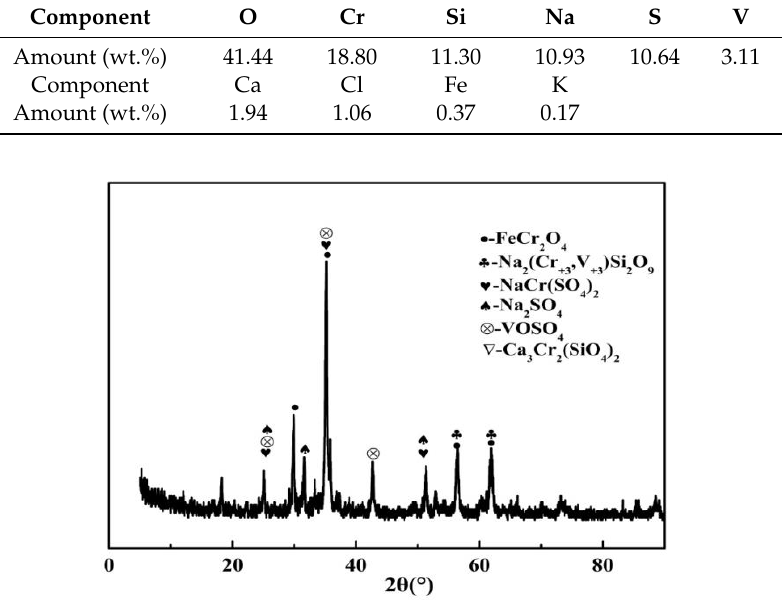
Figure 1. The XRD pattern of the original residue. Table 1. Composition of the vanadium – chromium reducing residue ( wt.%).